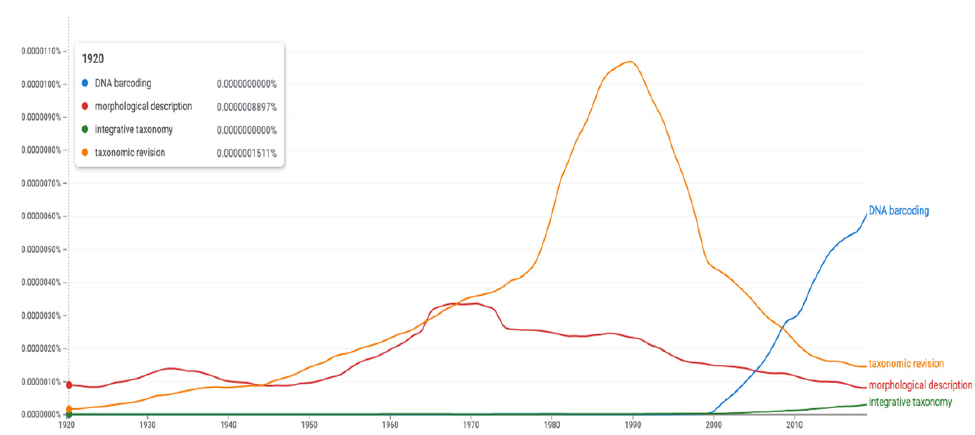
Figure 3. Google Ngram Viewer plot for the use of the terms “morphological description”, “taxonomic revision”, “DNA barcoding” and “integrative taxonomy” over the last century (1920 to 2019). Note that “morphological description” was more used hundred years ago compared to present day. Settings are “English 2019” dataset, “not case sensitive” and “smoothing 4” on a scale from 0 to 6. Link [13].